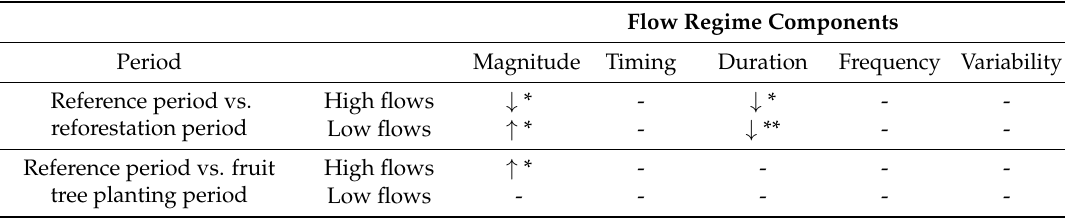
Table 1. The effects of forest changes on flow regimes in the Jiujushui watershed. Flow Regime